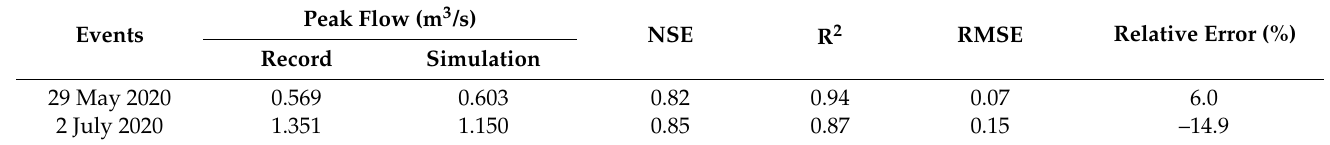
Table 3. Model validation results.